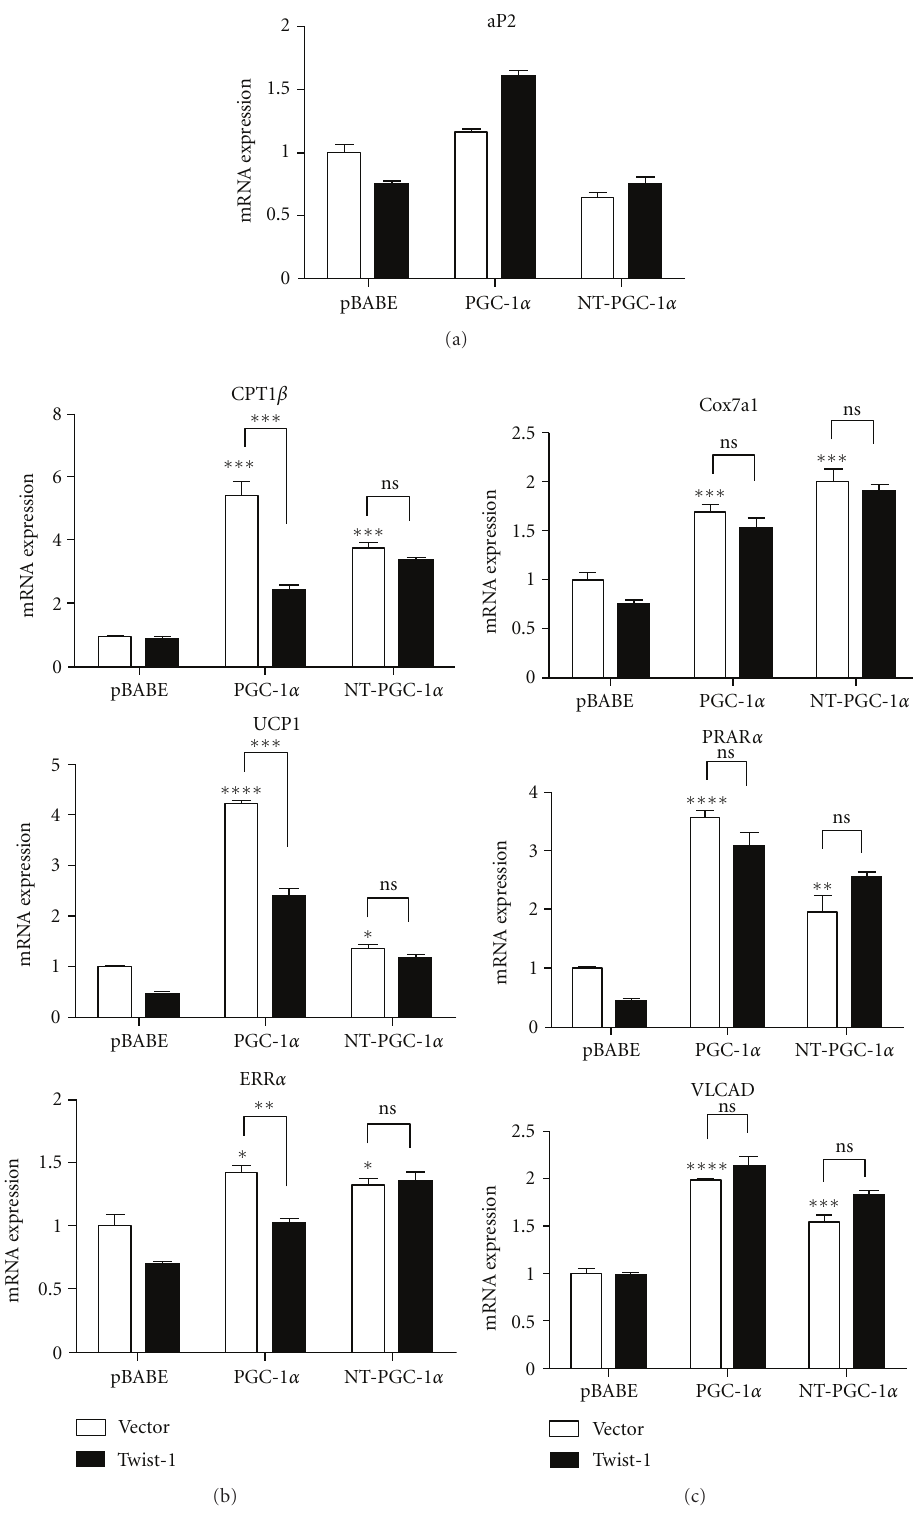
Figure 4: Di ff erential e ff ect of Twist-1 on PGC-1 α and NT-PGC-1 α target gene expression in brown adipocytes. (a), (b), (c) Quantitative real time PCR analysis of gene expression in di ff erentiated PGC-1 α - null brown adipocytes expressing empty vector (pBABE), PGC-1 α , and NT- PGC-1 α with empty vector (white bars) or Twist-1 (black bars). Relative abundance of mRNA levels was normalized to that of cyclophilin mRNA. Data represent mean ± SEM of at least four independent experiments. ∗ P < 0 . 05; ∗∗ P < 0 . 01; ∗∗∗ P < 0 . 001; ∗∗∗∗ P < 0 . 0001; ns: not